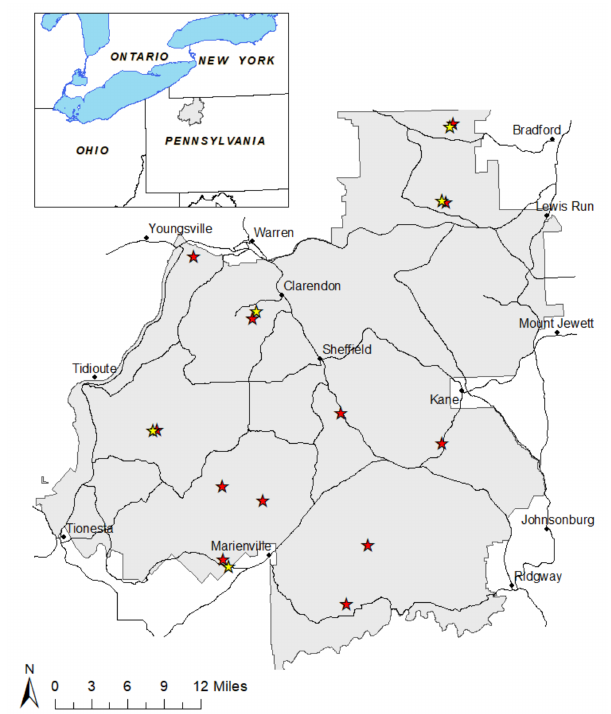
Figure 1. Map of the Allegheny National Forest with white ash foliar sampling locations denoted with stars (red stars denote low elevation and yellow sites upper elevation sites). Inset map denotes the position of the ANF in the greater